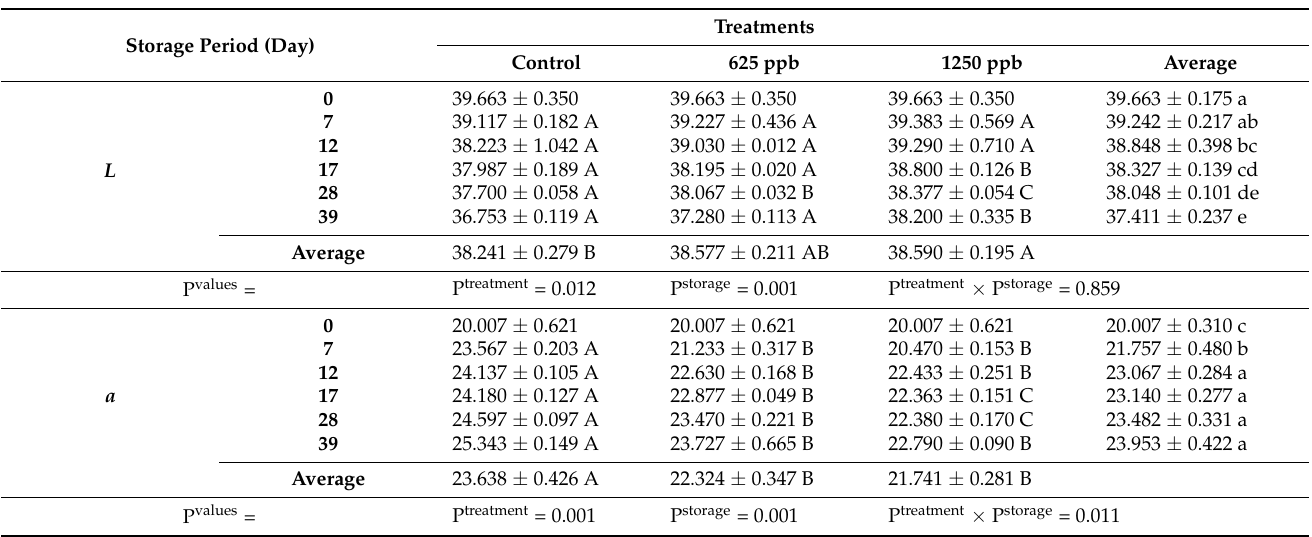
Table 3. The L* , a* , and ∆ E during storage of ‘Seyit F1’ cocktail tomato ( Solanum lycopersicum L.). Data are presented as means ±